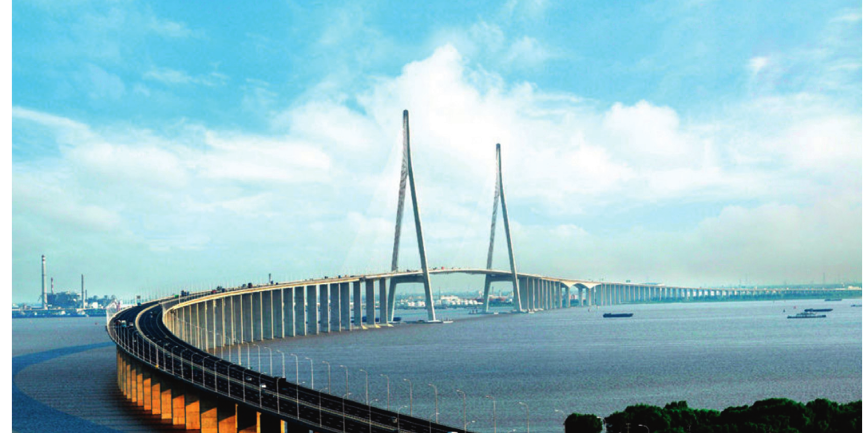
Figure 11: Photography of Sutong Bridge.